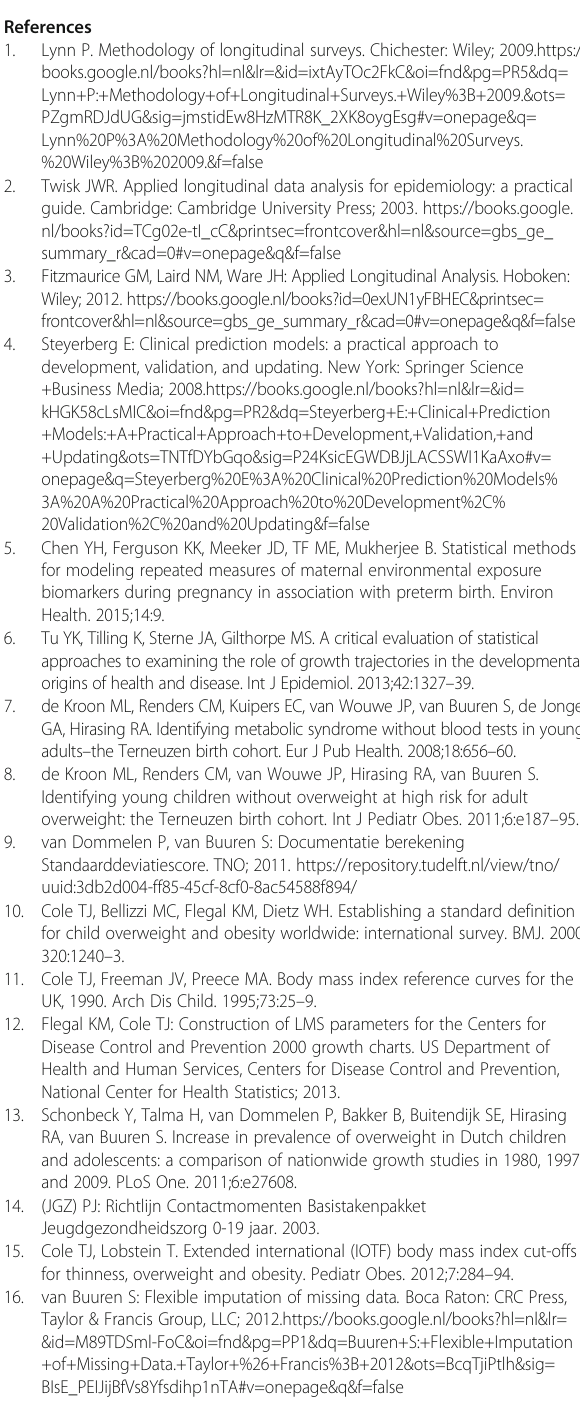
Additional file 1: Figure showing the structure of the original Terneuzen Birth Cohort data, the broken stick data, and the multiple imputed-data; Timing of BMI-SDS measurement for five selected participants of the Terneuzen Birth Cohort. (PDF 35 kb) Additional file 2: Information on (Text S1) and results of (Figure S2 and Tables S1-4) the analyses reproduced in the multiple imputed dataset.